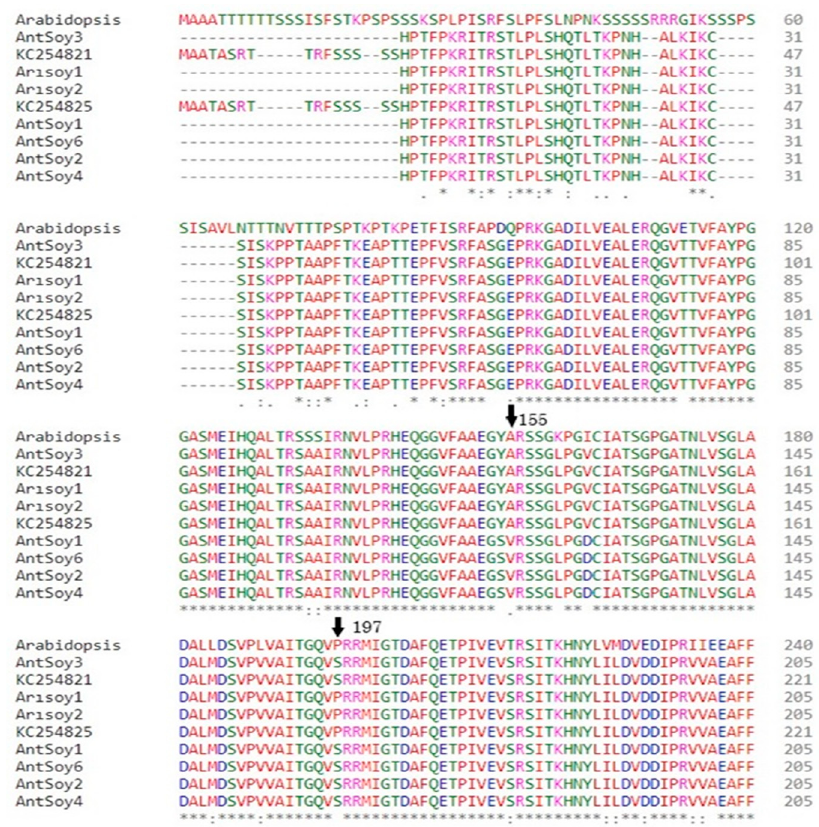
Figure 3. Alignment image made with Mega-X program. KC254821 (1) and KC254825 (9) resistant and sensitive plant reference sequence, respectively. 2, 3, 4, 5 and 6 were the progeny of AntSoy. 7 and 8 were herbicide sensitive Ar ı soy variety (the wild type)